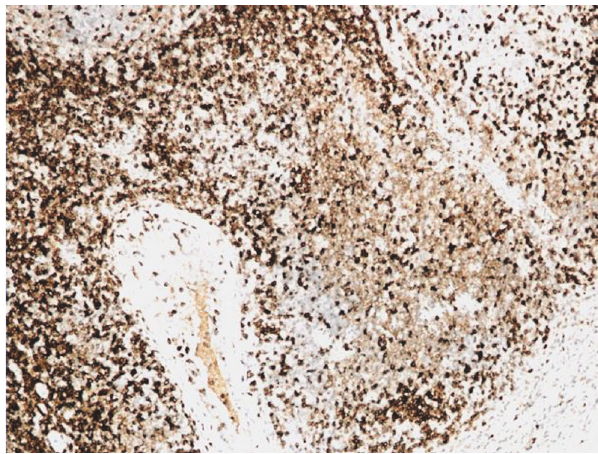
Figure 8: Mantle cell lymphoma (100x). Positive staining with SOX 11.